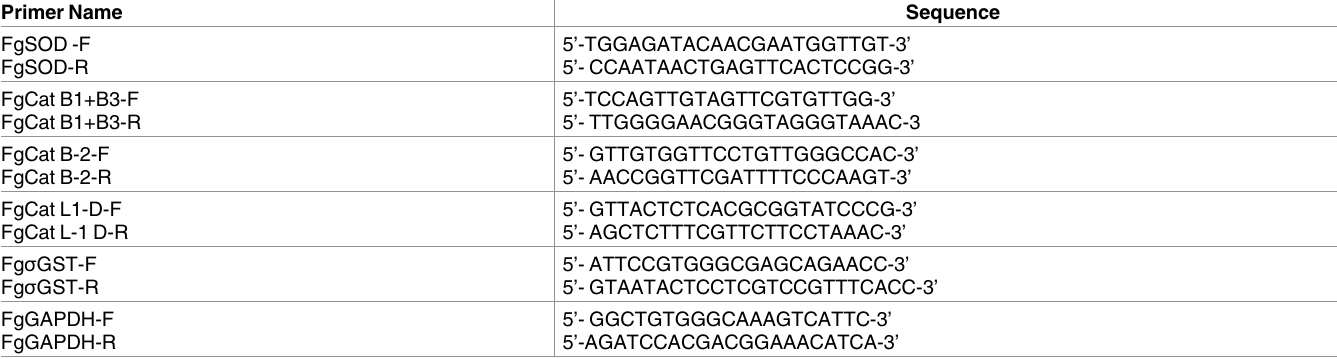
Table 2. Primers designed for qRT-PCR estimation of the mRNA transcript knockdown of F . gigantica target genes post-RNAi. Primer